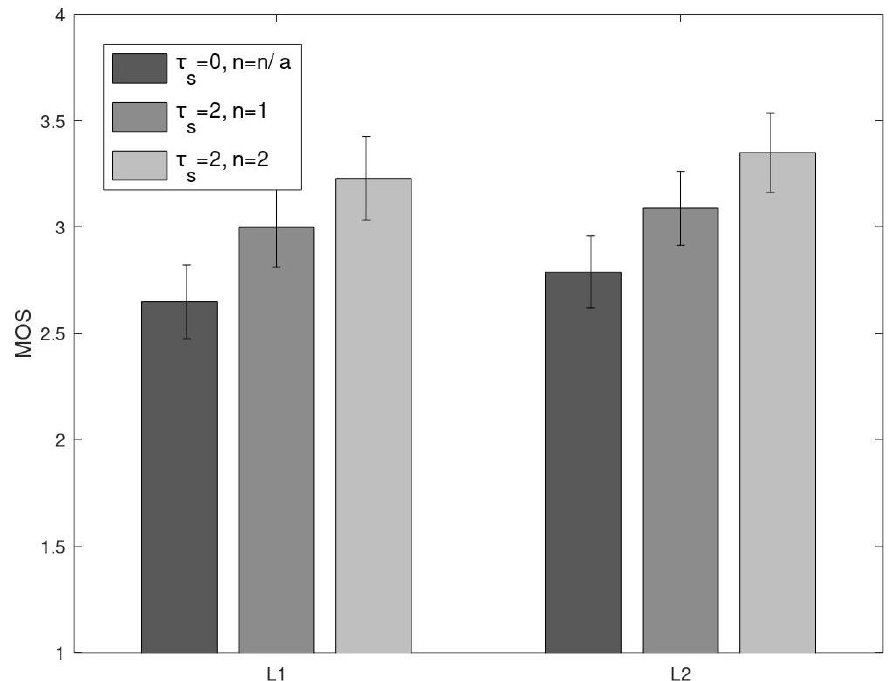
Figure 7. MOS with 95% confidence intervals of the “Football” video with two outage locations for τ j = 1 and τ o =